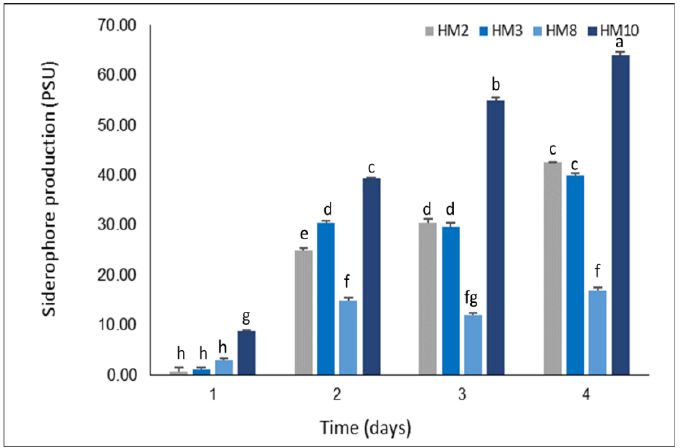
Figure 3. Represents the quantified production of siderophore by the four Streptomyces strains in King’s broth medium. Bars not sharing similar letters are significantly different ( p > 0.05).